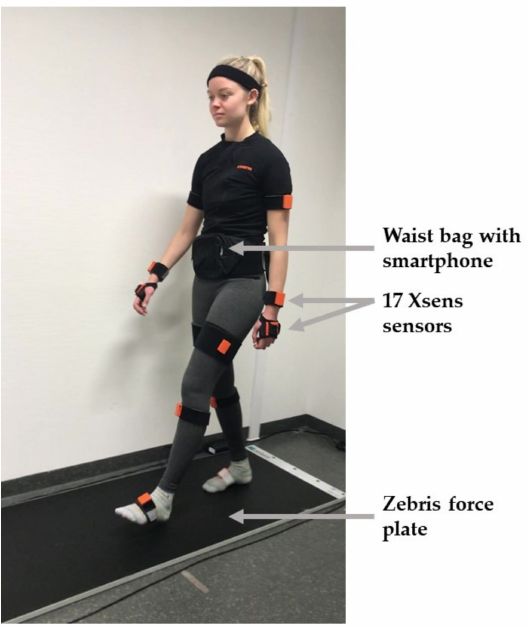
Figure 2. Representation of the three gait analysis systems used in the